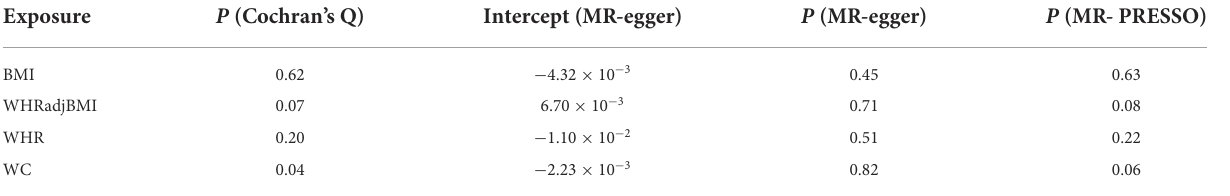
TABLE 2 Sensitivity analysis for the associations between BS and risk of